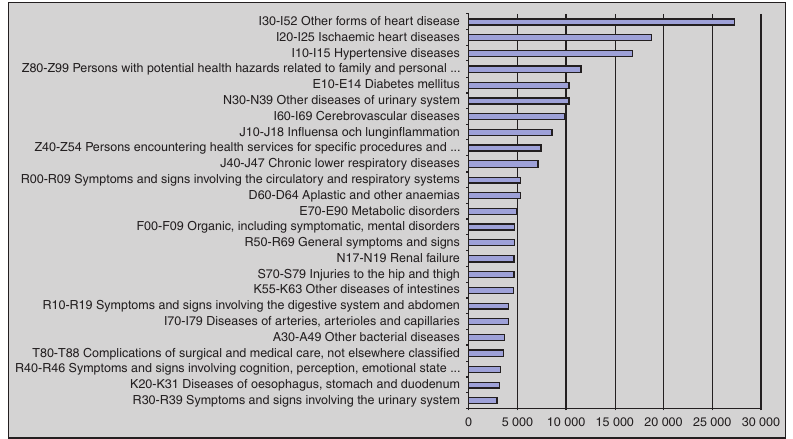
Figure 4. The most common diagnostic sectors of the multiple-diseased elderly patients with a manifested cardio v ascular disease